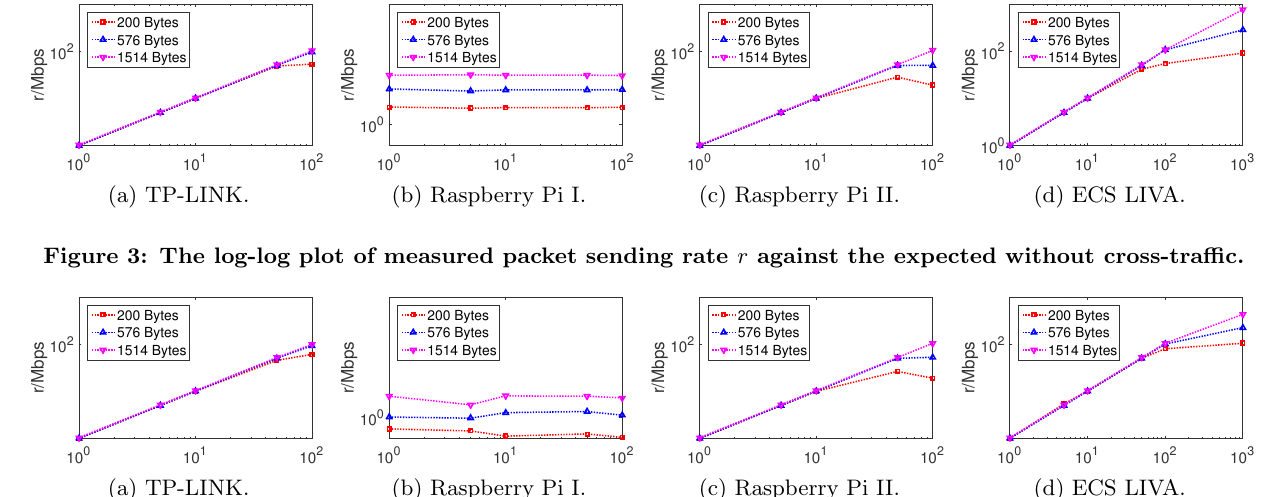
10 0 Expected packet sending rate/ Mbps Figure 4: The log-log plot of measured packet sending rate r against the expected with cross-traffic (25 flows).